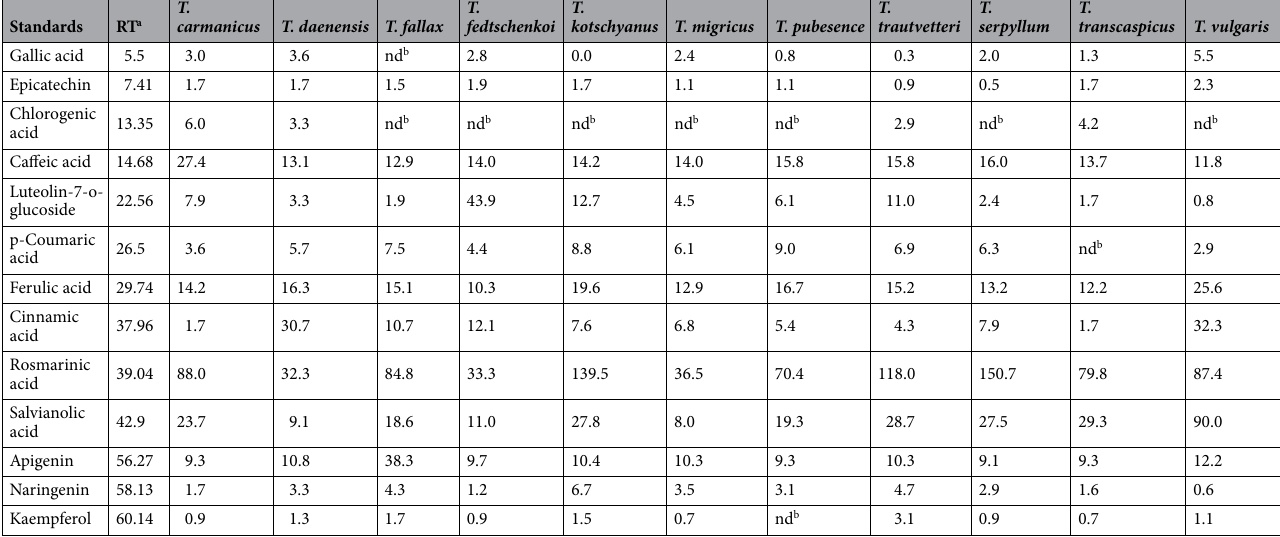
Table 1. Major phenolic and flavonoid compounds of the studied Thymus species based on HPLC analysis. The values are expressed in mg/100 g of sample dry weight. a The data were sorted based on the retention time (RT) of components. b (nd): Not